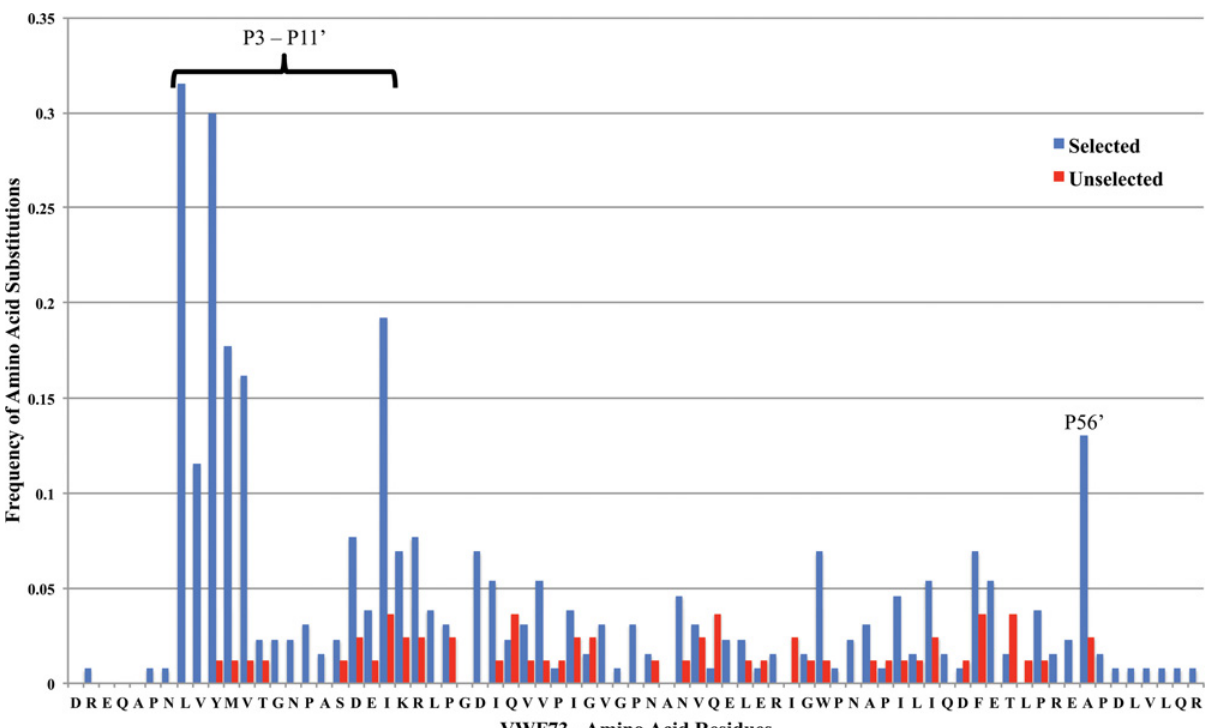
Fig 3. Mutation frequency across VWF73 phage. The mutation frequency was calculated at each position in 130 phage recovered from screening experiments for resistance to ADAMTS13 cleavage and in 82 phage randomly selected from unscreened libraries.